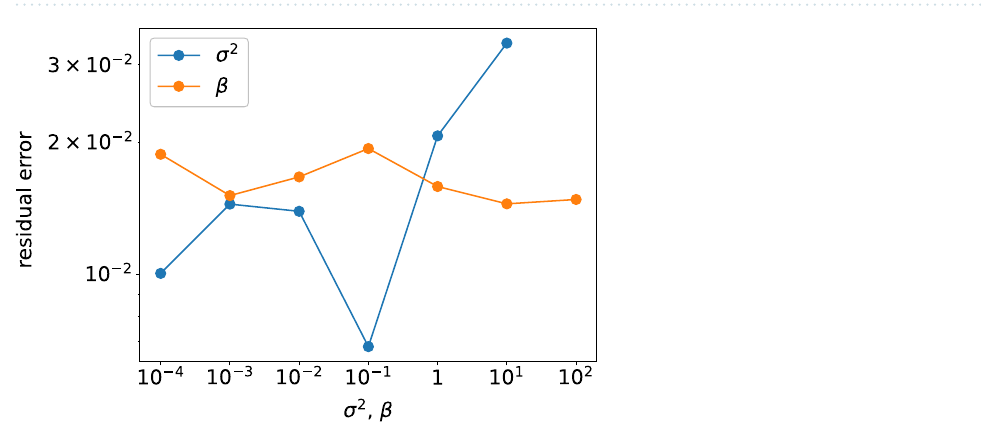
Figure 5. ( a ) 48 exact solutions for the first instance. Each box represents a 3 × 8 matrix M . Black and white pixels represent 1 and − 1 , respectively. ( b ) clustering results of the 48 exact solutions by the Ward method. Each solution is labelled from 0 to 47 and assigned left-to-right and top-to-bottom in ( a ).